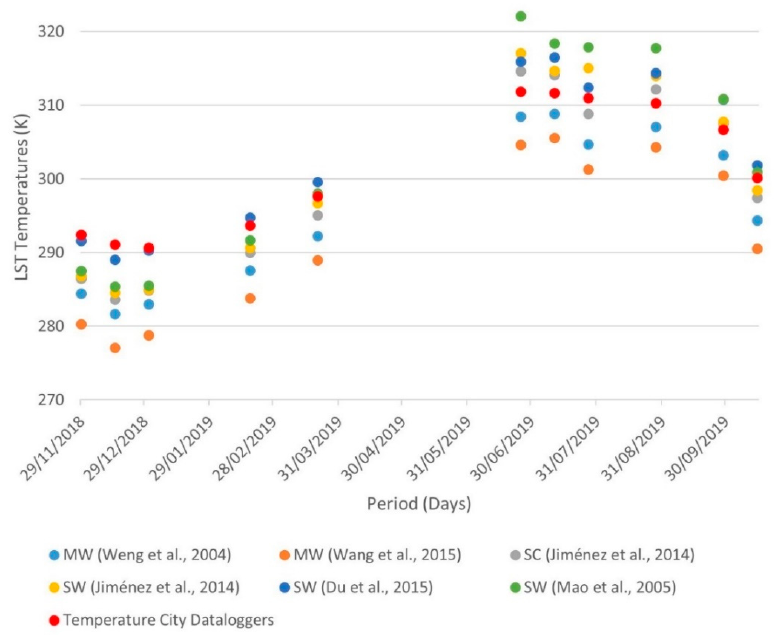
Figure 4. LST mean of every algorithm by date.